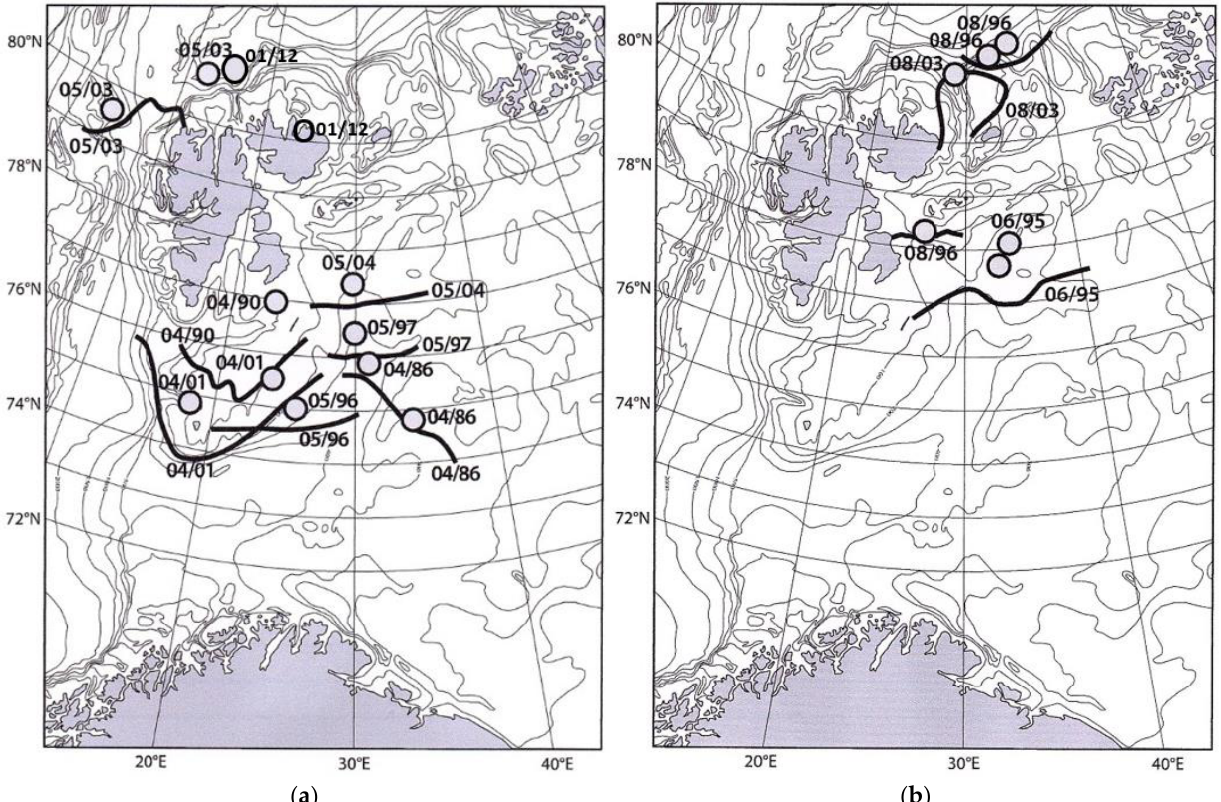
Figure 1. Map of the sampling area for ice algae in the Barents Sea 1986 – 2012. ( a ) Winter and spring cruises (January – May), ( b ) Summer/autumn cruises (June – September). Lines mark the average ice border for each cruise, numbers mark the month and year.